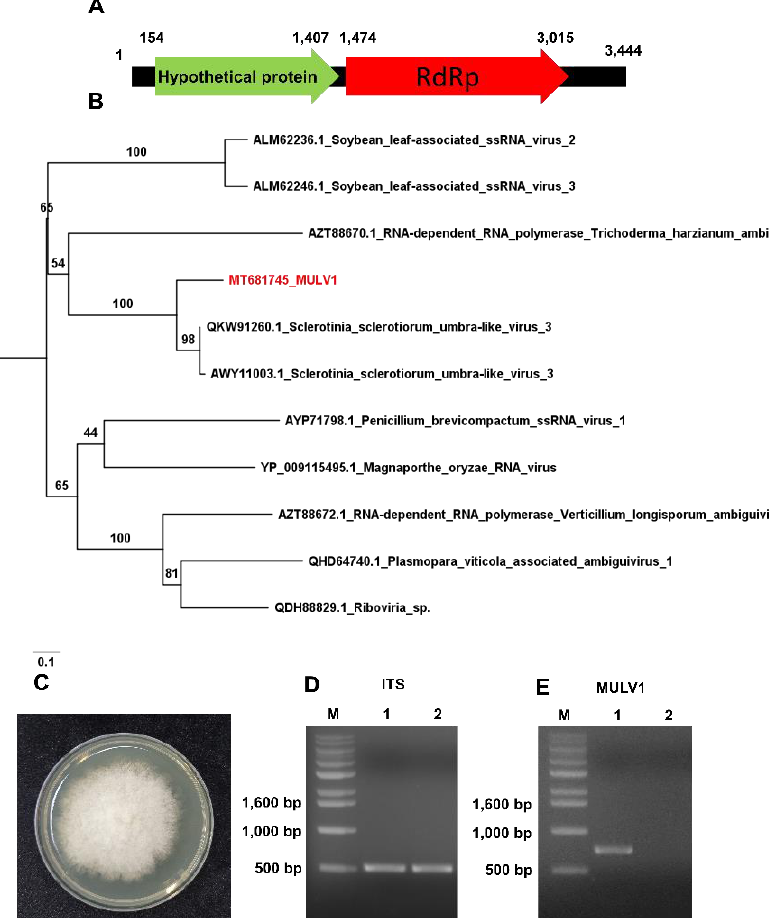
Figure 8. Genome organization and phylogenetic relationship of novel mycovirus (MULV1). ( A ) Genome organization of MULV1. Numbers indicate positions of open reading frames (ORFs). ( B ) Phylogenetic relationship of MULV1 and closely related viruses. The phylogenetic tree was inferred by IQ-TREE with the maximum likelihood method and 1000 bootstrap iterations. ( C ) Isolated Monilinia fructigena from the mummified peach fruit (S4 sample) grown on potato dextrose agarose (PDA) medium. ( D ) Identification of M. fructigena by PCR using internal transcribed spacer (ITS) primers. M indicates DNA ladder. 1 and 2 indicate Monilinia species from the mummified peach fruit (S4 sample) and other peach fruit, respectively. ( E ) RT-PCR results using MULV1 specific primers. The amplicon size is 737 bp.